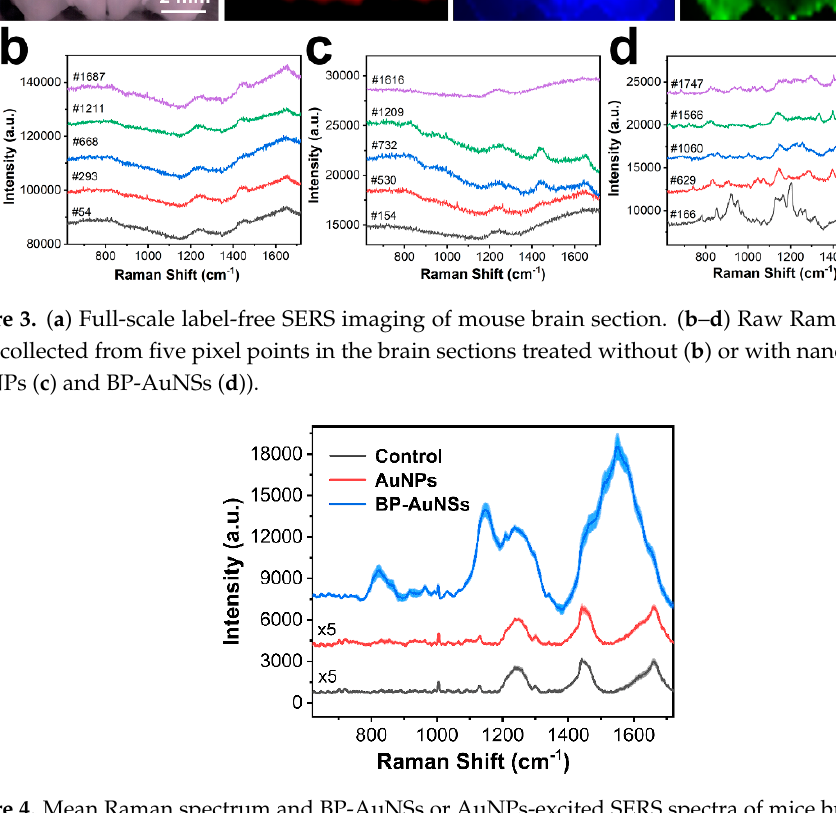
Figure 4. Mean Raman spectrum and BP-AuNSs or AuNPs-excited SERS spectra of mice brain tissues, shade areas represented the standard deviations.